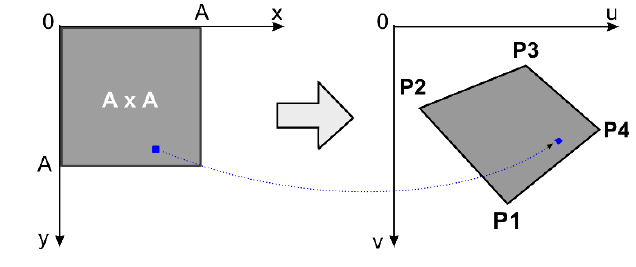
Figure 14. Perspective transformation.